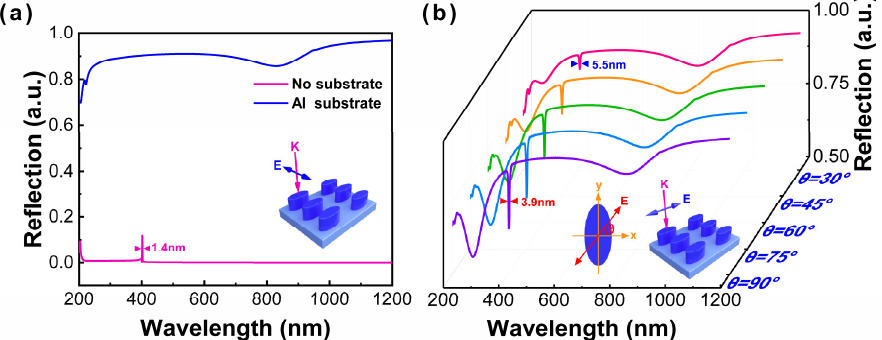
Figure 3. ( a ) Reflectance spectra of an Al nanoellipse metasurface on the Al substrate. ( b ) Reflectance spectra of an Al nanoellipse metasurface under different polarization angles from 30° to 90° corresponding to the pink solid line to the purple solid line.